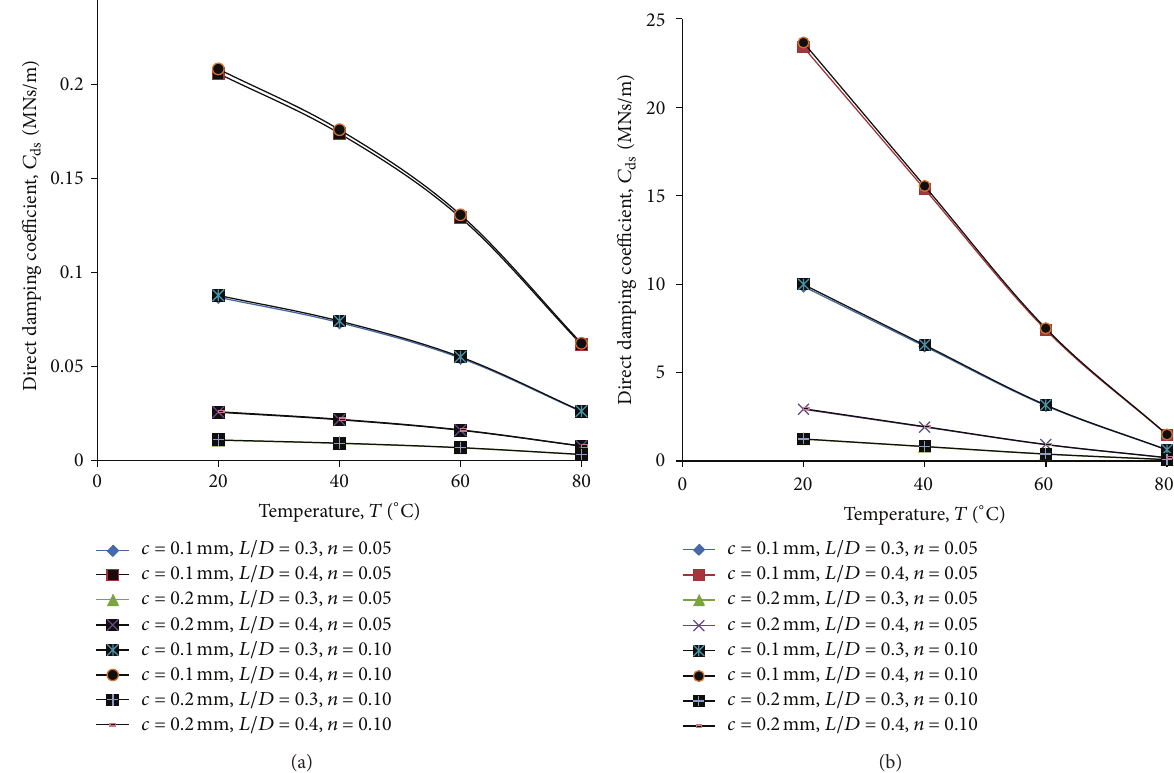
Figure 5: Direct damping coefficient, 𝐶 , (MNs/m) versus temperature, ( ∘ C) for (a) 𝐸 = 0 kV/mm and (b) 𝐸 = 2.5 kV/mm under a constant ds strain rate, ̇𝛾 = 2 s −1